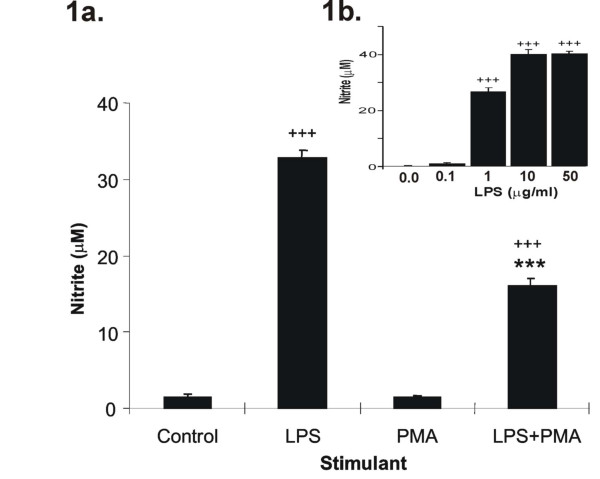
a. The effect of PMA on LPS stimulated NO production in RAW 264.7 cells. RAW cells were stimulated for 24 hr with either vehicle alone (control), 1 μg/ml LPS, 50 ng/ml PMA or 1 μg/ml LPS with 50 ng/ml PMA. NO levels were assessed by Greiss assay. LPS alone significantly increased NO production whereas PMA alone had no effect. PMA significantly inhibited LPS -stimulated NO production. Figure 1b (inset) displays the concentration-response curve for LPS-stimulated NO production over 24 hrs. Results are expressed as mean ± SEM; +++p < 0.001 vs control, ***p < 0.001 vs LPs-stimulated; n = 6 for the effects of PMA and n = 9 for the concentration-response curve.